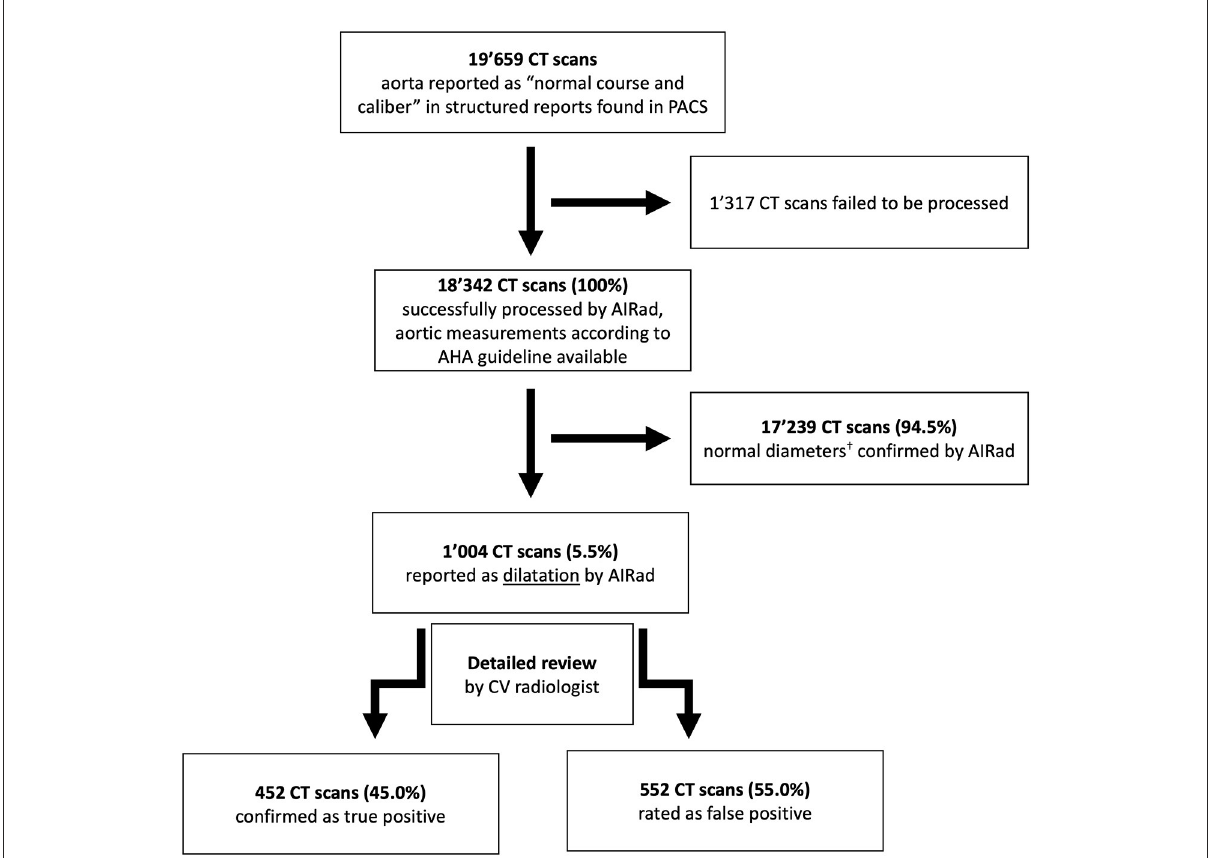
FIGURE1 Flow chart. † < 45mm for aortic sinus, sinotubular junction, ascending aorta and proximal arch or < 40mm at mid and distal arch, mid and distal descending aorta and abdominal aorta. AHA, American Heart Association; CV,